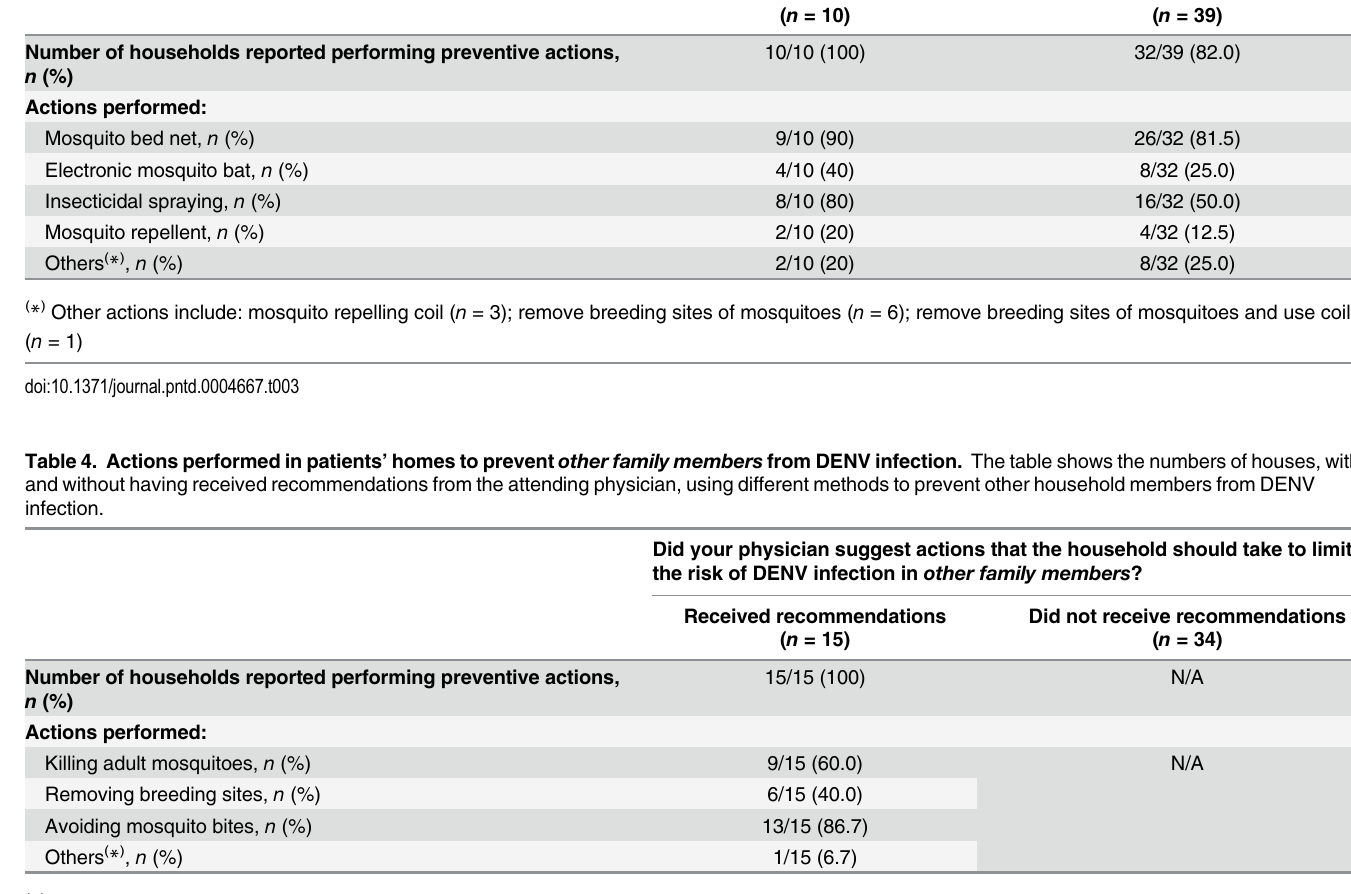
Table 3. Actions performed in patients ’ homes to prevent the patients from mosquito bites. The table shows the number of houses, with and without having received recommendations from the attending physician, using different methods to prevent the patient in the household being bitten by mosquitoes. Did your physician suggest speci fi c actions to stop the patients being bitten by mosquitoes?